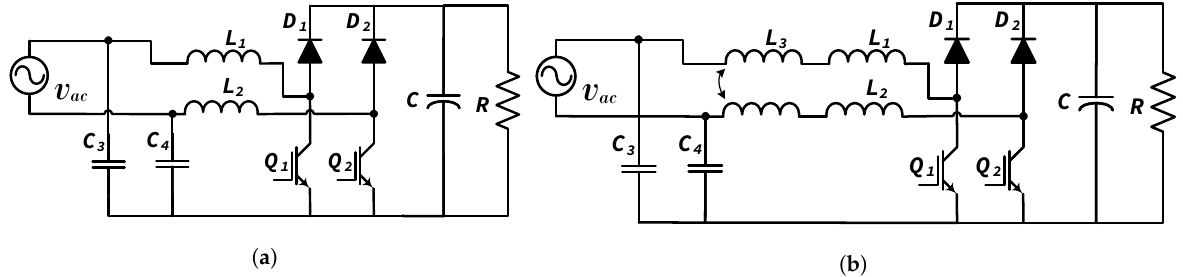
Figure 13. Semi-bridgeless boost topology with clamped capacitors: ( a ) conventional; ( b ) coupling